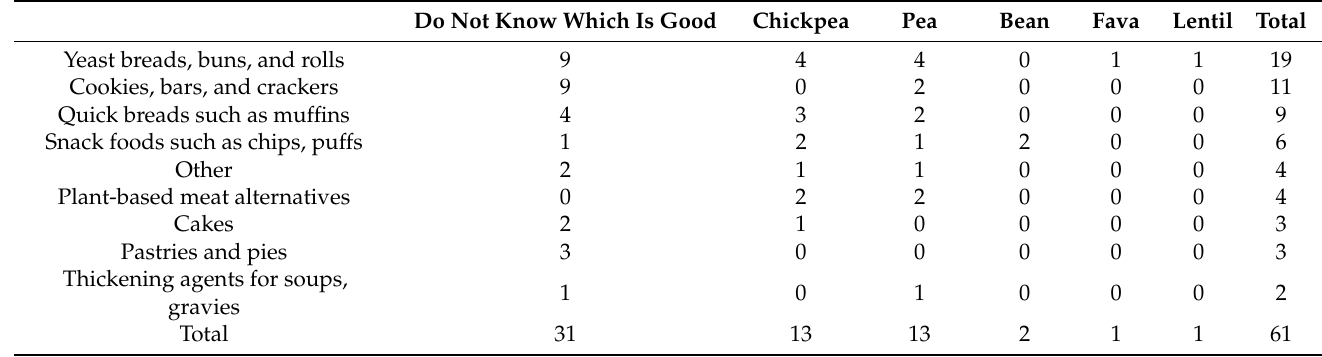
Table 4. Pulse flour type and product type that participants are using, previously used, considered using, or interested in using. A total 14 of “Not interested” or no answers were excluded from this